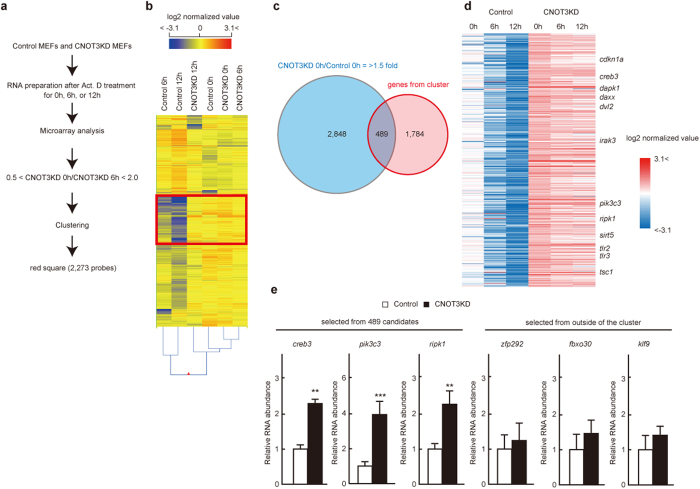
Microarray analysis of RNA following transcriptional inhibition identifies CNOT3-regulated mRNAs.(a) Procedure for selection of genes, the stability of which is affected by CNOT3 suppression. (b) Heat map after a hierarchical clustering. A red square indicates a cluster in which transcripts are largely decreased in controls, but not CNOT3KD MEFs after Act. D treatment. (c) Venn diagram illustrating the overlap between the gene selected from (b) (circled red) and genes up-regulated >1.5 fold in CNOT3KD MEFs compared with control MEFs (circled blue). (d) Heat map showing relative expression levels of the overlapped 489 genes in (c). (e) qPCR analysis of mRNAs in control or CNOT3KD MEFs. gapdh mRNA levels were used for normalization. n = 3 for each genotype. All values represent means + sem. **P < 0.01; ***P < 0.001